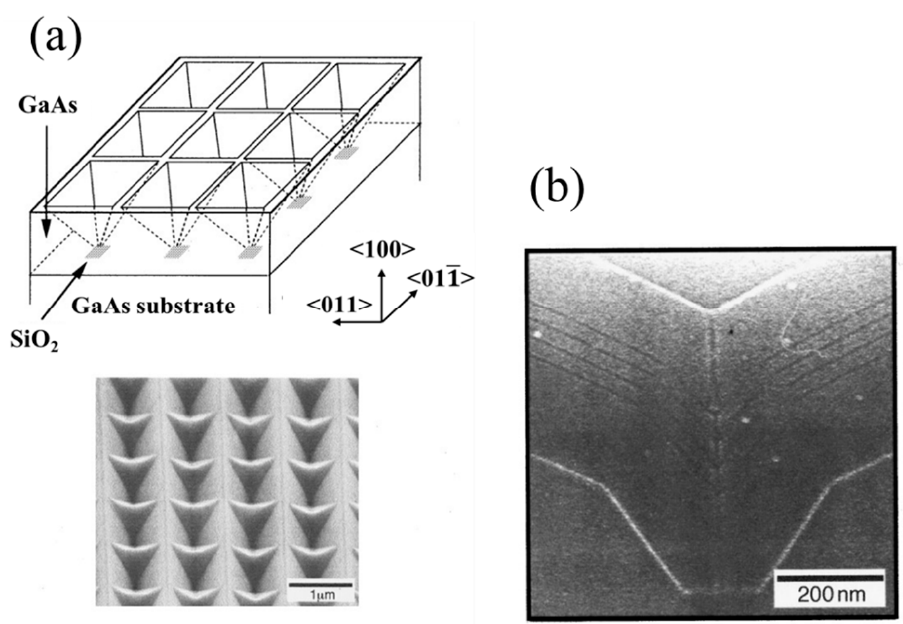
Figure 4. ( a ) Schematic of the patterned GaAs substrate and ( b ) TEM image of four stacks QD struc- tures. Reproduced with permission from [50]. AIP Publishing, 1998.